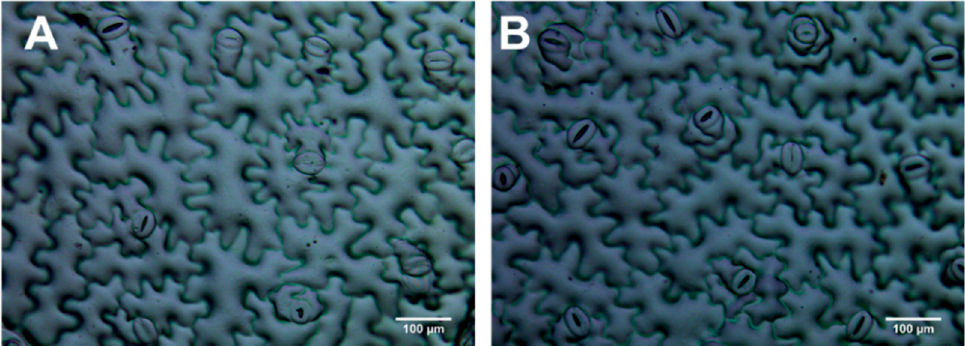
Figure 6. Microscopy images of the adaxial side of ( A ) AN1 and ( B ) WT leaves (20×).